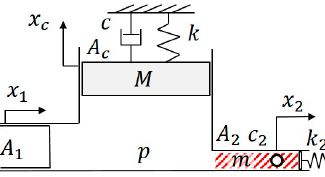
Figure 2. The proposed mechanical model for describing the relation between the movement between a macro actuator ( x 1 ) and a micro object ( x 2 ). The model describes the dashed box area shown in Figure 1